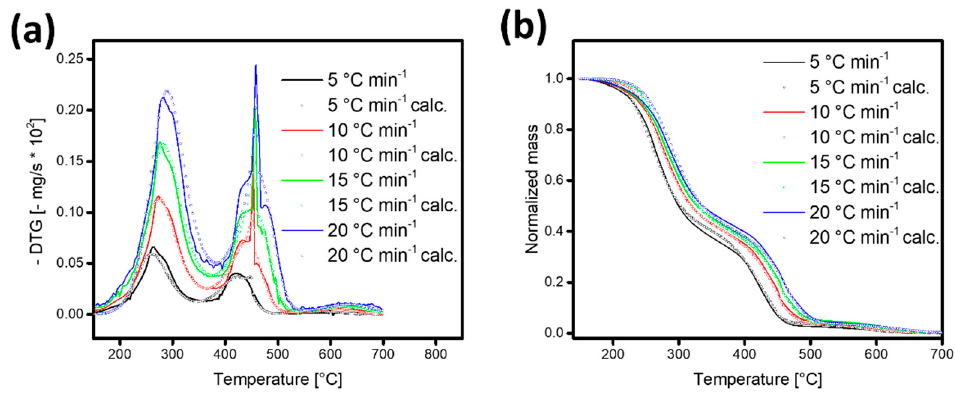
Figure 4. Fit of CPH thermal decomposition experiments in oxidizing atmosphere. ( a ) DTG, ( b ) TG.